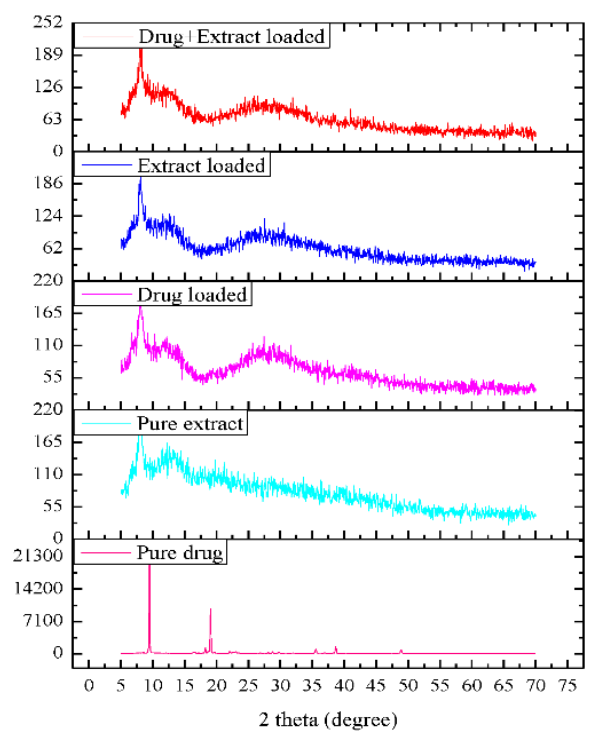
Figure 4. PXRD pattern of active ingredients and the topical gels.